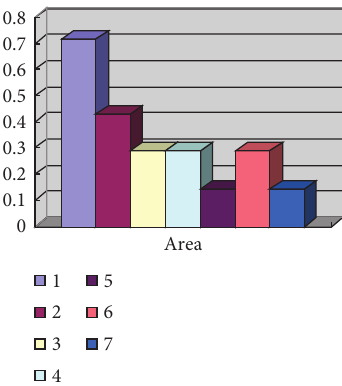
Figure 2: Proportion of the number of adjacent regions in each region of the original image in Figure